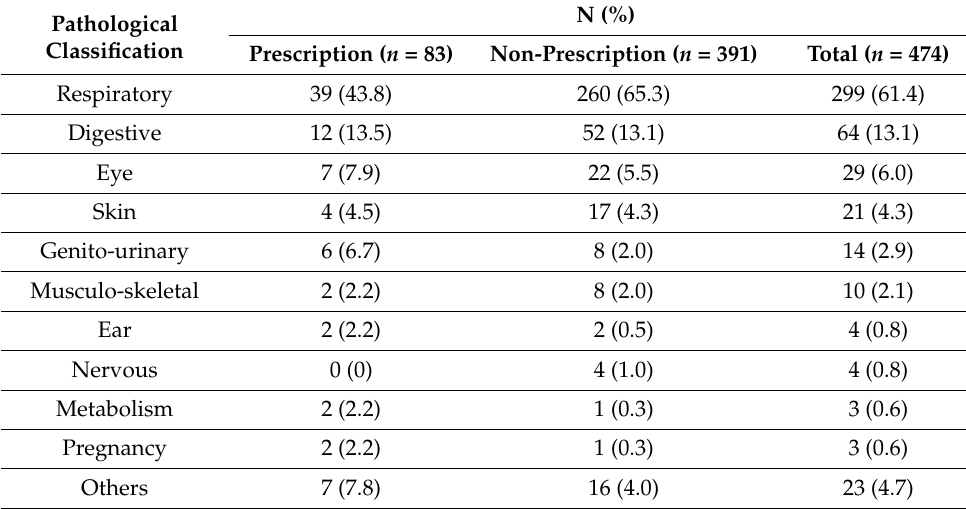
Table 3. Pathological classification of purchased